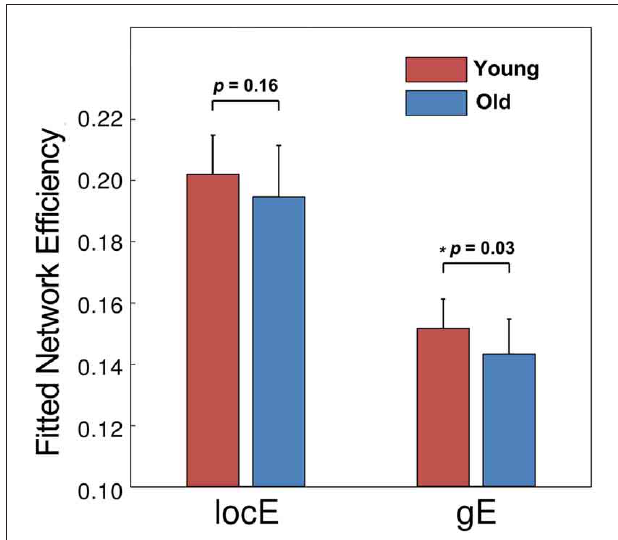
FIGURE 7 | The group comparison of network efficiency. The old group showed a significant reduction of global efficiency and a trend of reduction in local